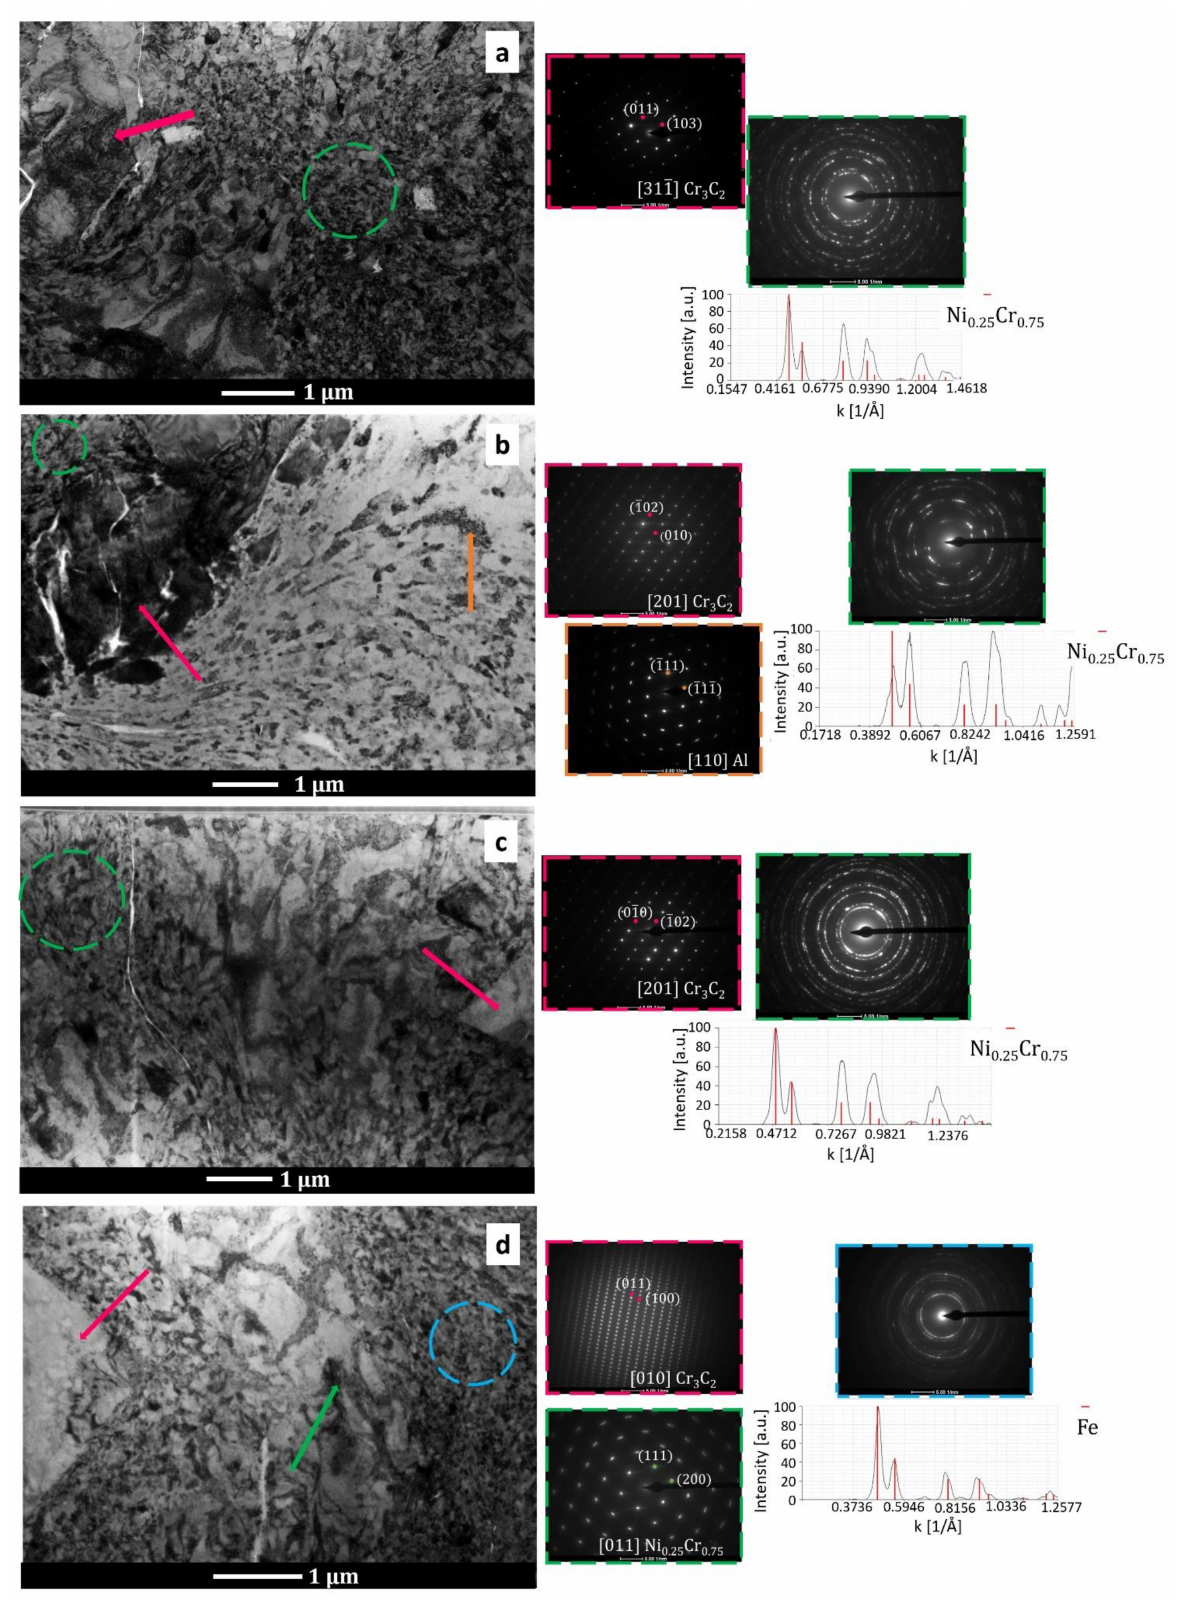
Figure 6. Bright-field TEM images and selected-area diffraction patterns in the areas showing the coating structure in the central part of the coating sprayed on the Al alloy ( a ), near the Al substrate ( b ), in the central part of the coating sprayed on steel ( c ), and near the steel substrate ( d